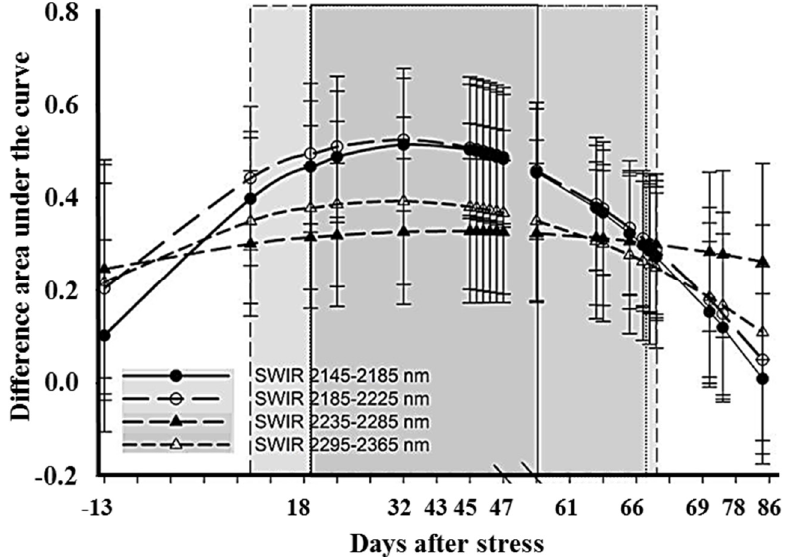
Figure 8. Model-based estimated difference for the area under the curve for SWIR regions 2145–2185, 2185–2225, 2235–2285 and 2295–2365 nm. The shaded areas show the time points that were statistically different. The break in the horizontal axis between 47 and 52 days after stress separates the period of water stress from recovery. Error bars are the standard errors; n =